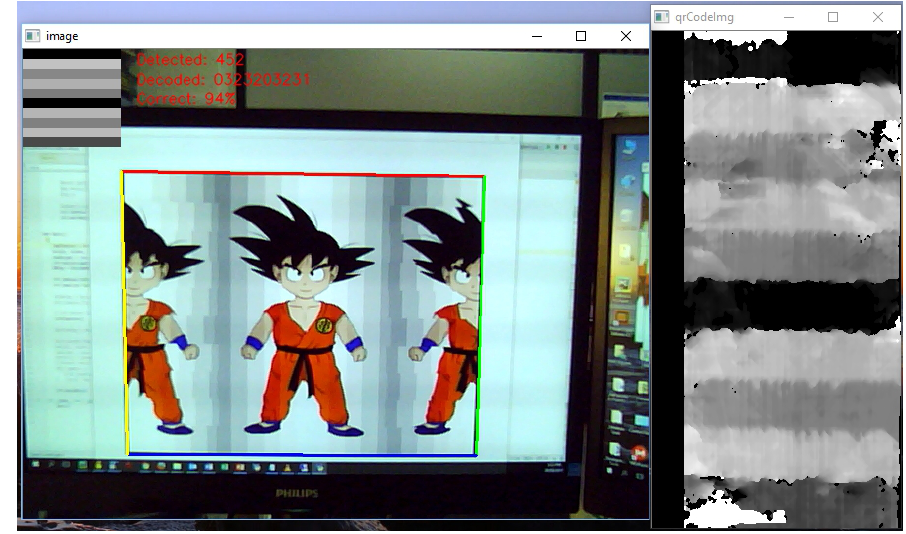
Figure 15. Screenshot 2 of the tag detection and